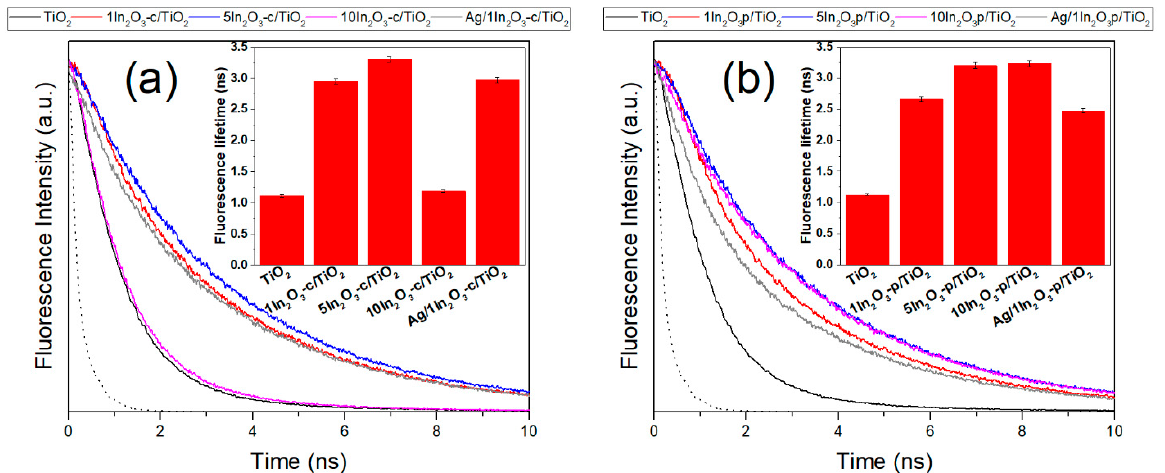
Figure 4. Fluorescence decay curves (main graphs) and fluorescence lifetimes obtained from fittings (insets), for the c-series ( a ) and the p-series ( b ) catalysts. Dotted lines represent the instrument response function.